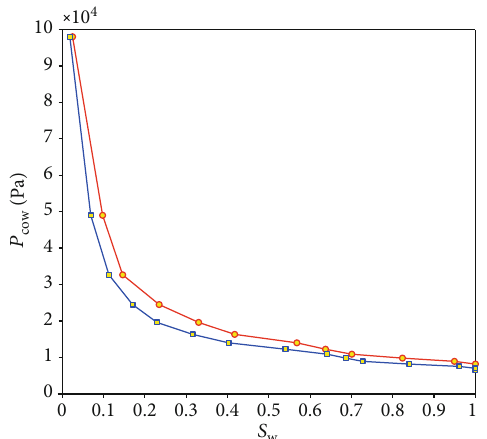
Figure 13: Two-phase oil-water capillary pressure curves in the sandstone image as computed with the semianalytical model. (Red curve: θ = 0 ° ; blue curve: θ = 40 ° ow ow